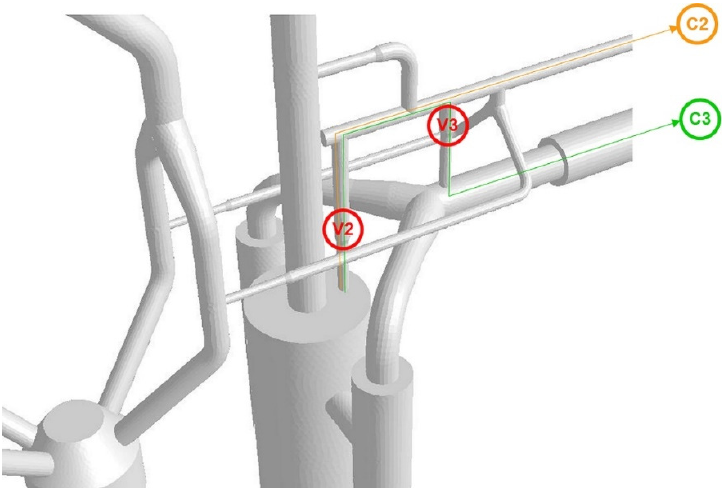
Figure 8. Detailed view of the scheme of the three compared circuits of BF gas. C2 and C3 are the second and the third analyzed circuit, respectively. V2 is the cyclone inlet and V3 is the cyclone outlet.